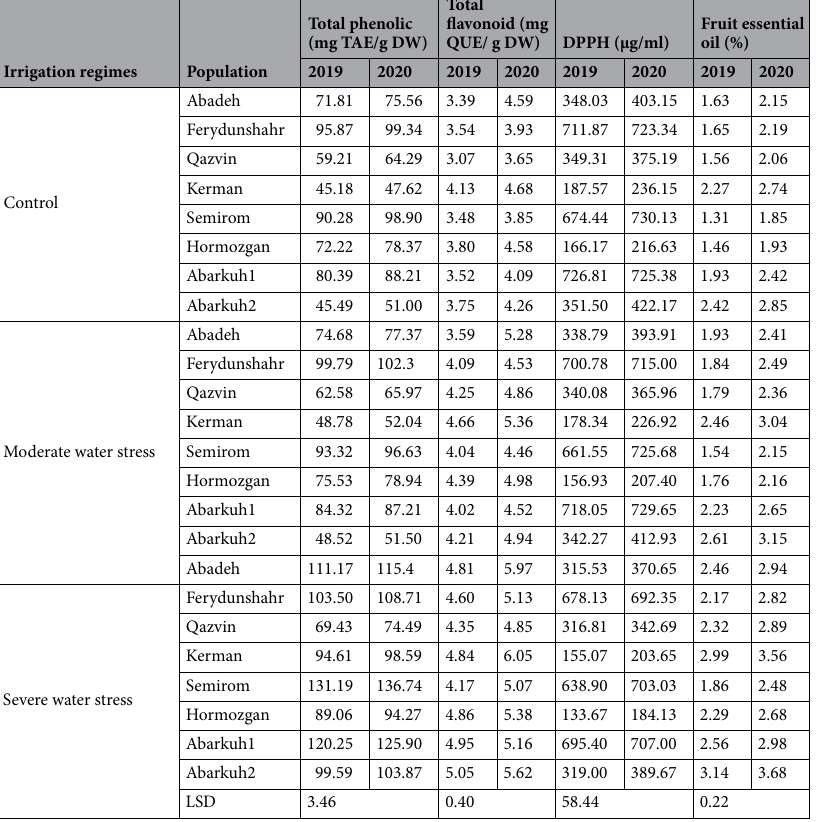
Table 2. Mean comparisons of irrigation regimes, years and populations (interaction) on phytochemical traits of 8 Moshgak population. In each trait, means having difference less than the LSD provided are not significantly different (p <